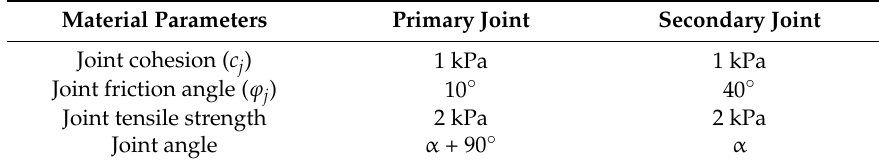
Table 3. Mechanical properties of jointed rock mass (different joint friction angle).